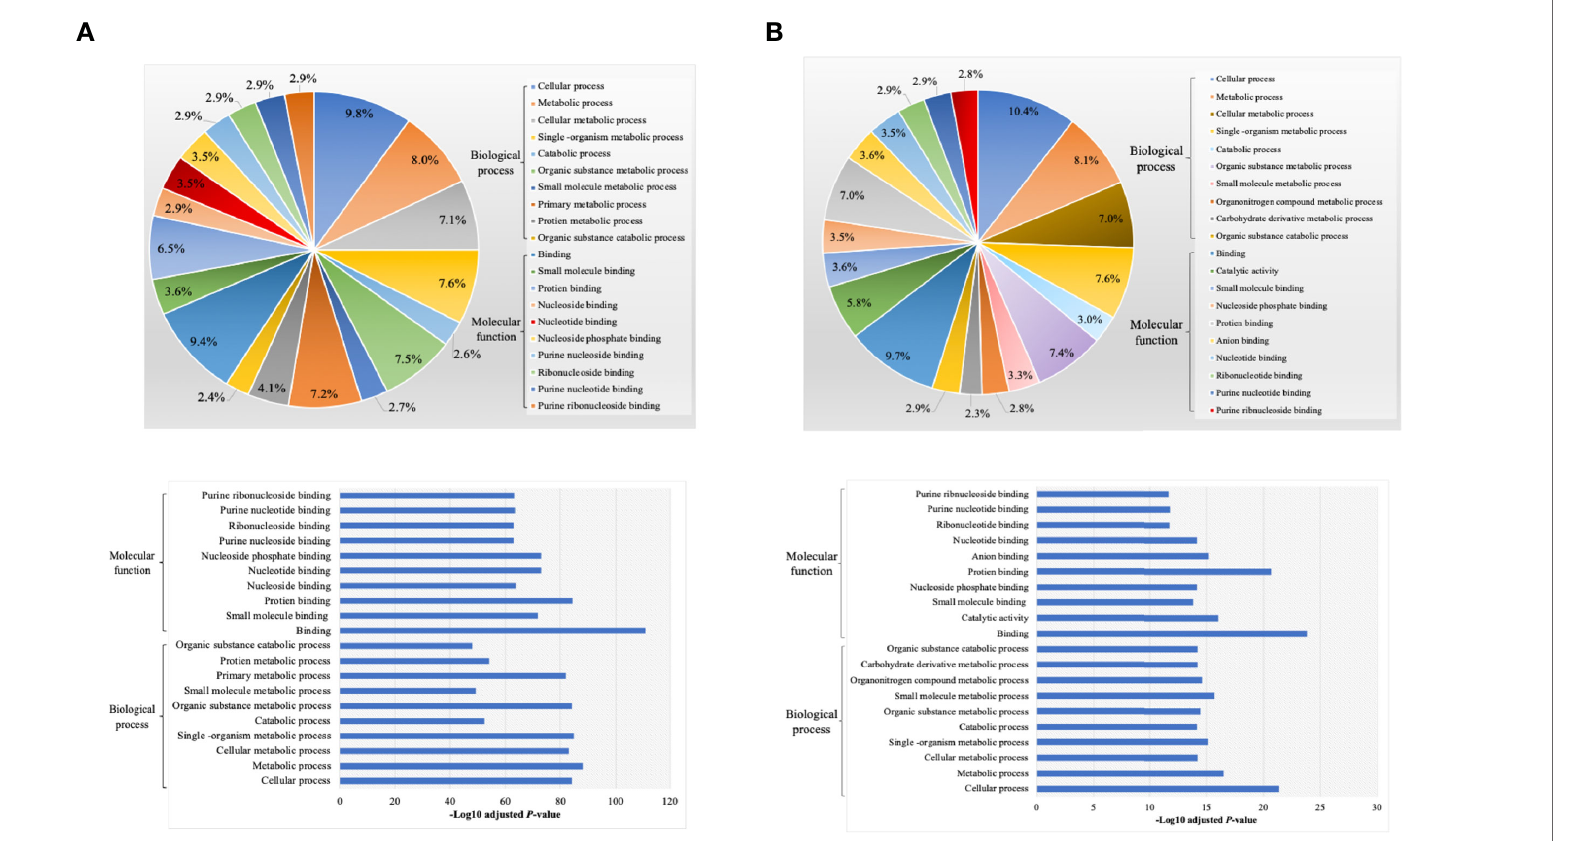
FIGURE 8 | Gene ontology (GO) enrichment of proteins (A) non differentially expressed and (B) differentially expressed proteins between DCs exosomes subsets, listed on their percentage (upper panel) and level of signi fi cance (lower